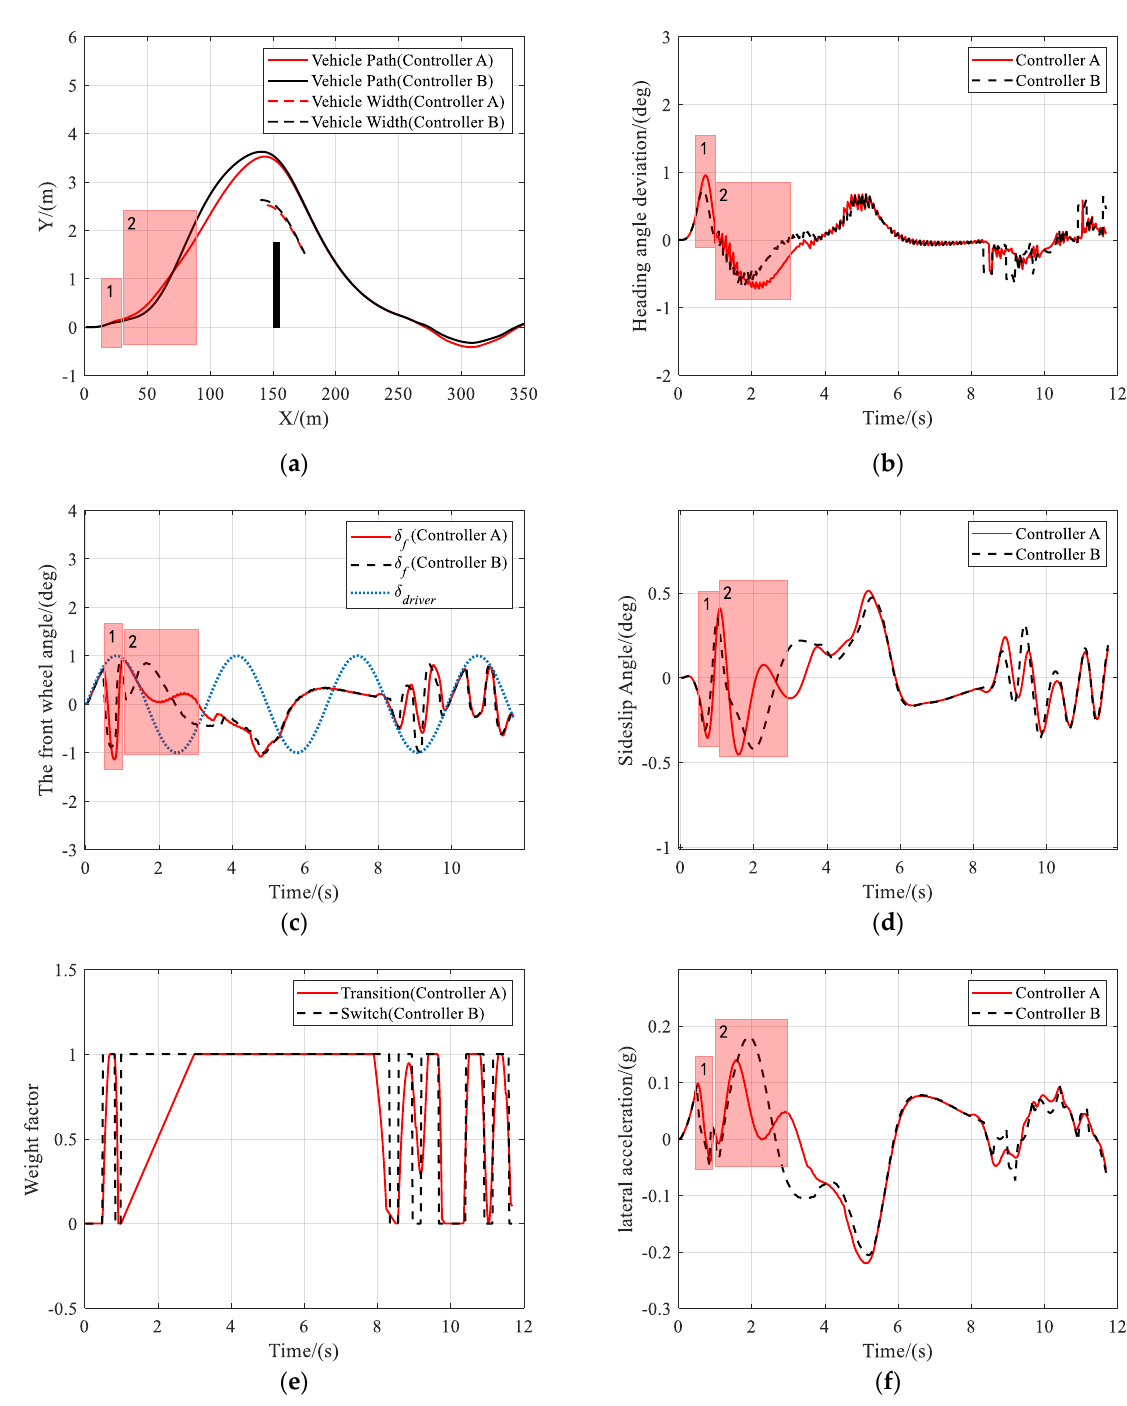
Figure 10. Scenario 2: Simulation results at 108 km/h. ( a ) Vehicle trajectory, ( b ) heading angle deviation, ( c ) the front wheel angle, ( d ) sideslip angle, ( e ) weight factor, and ( f ) lateral acceleration.